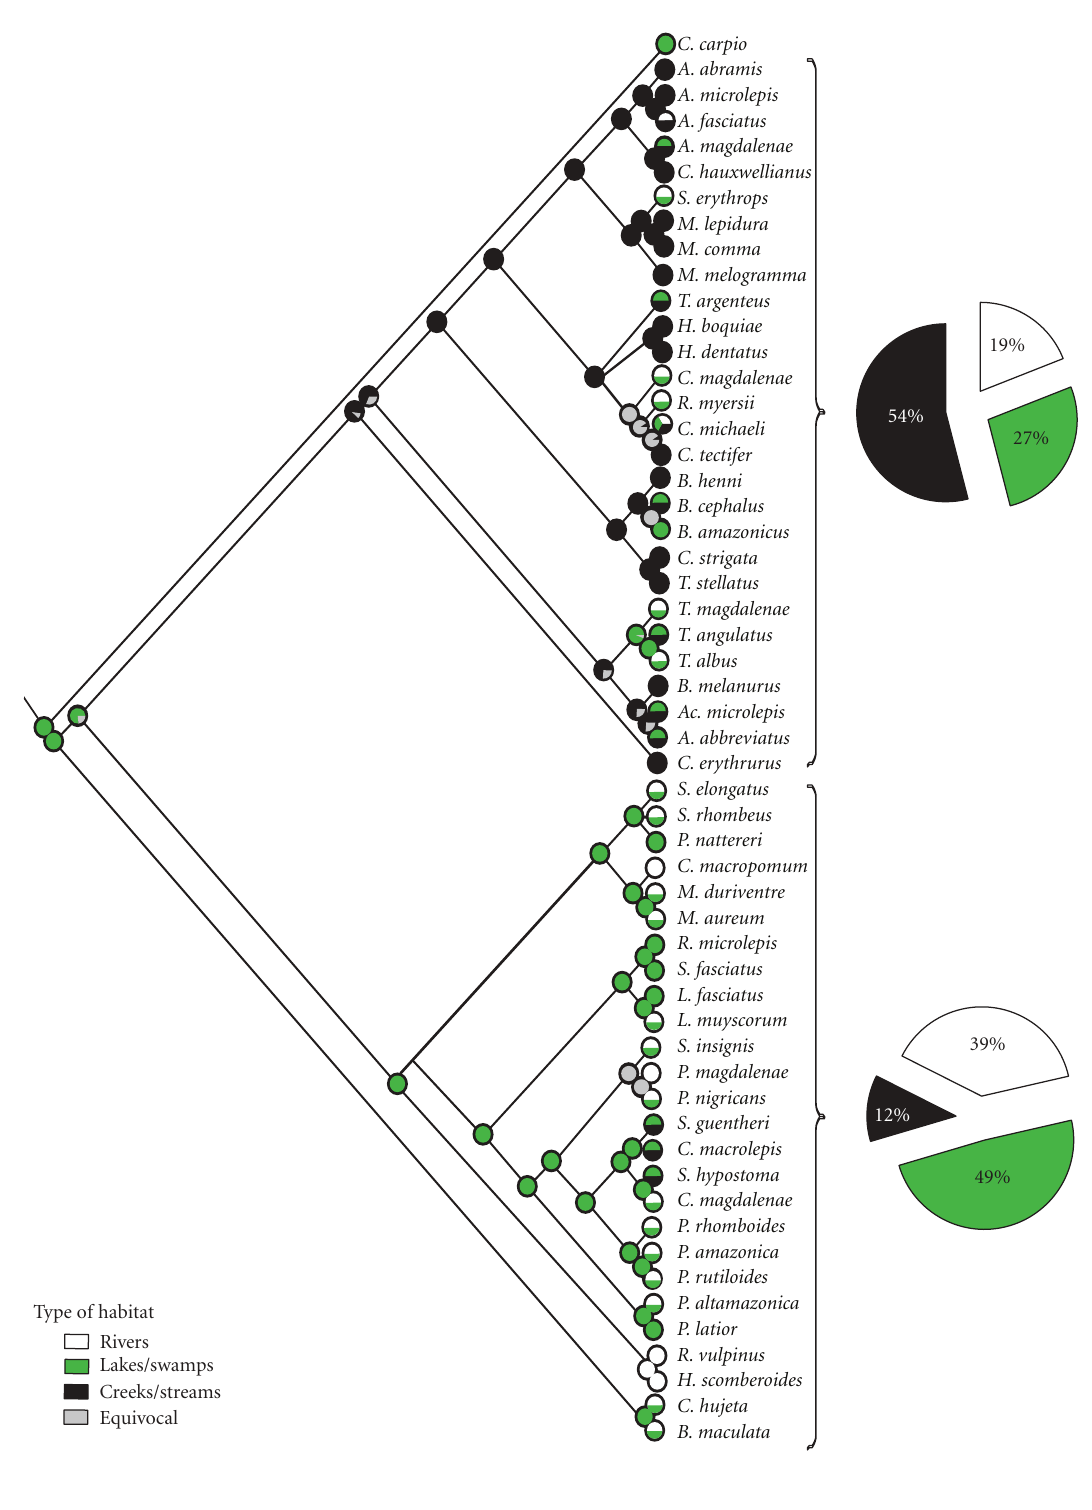
Figure 8: Reconstruction of habitat shown on consensus tree in 800 trees with Bayesian inference. Pie charts at major nodes show posterior probabilities from stochastic analysis of ancestral state reconstructions assuming that character-state evolution is